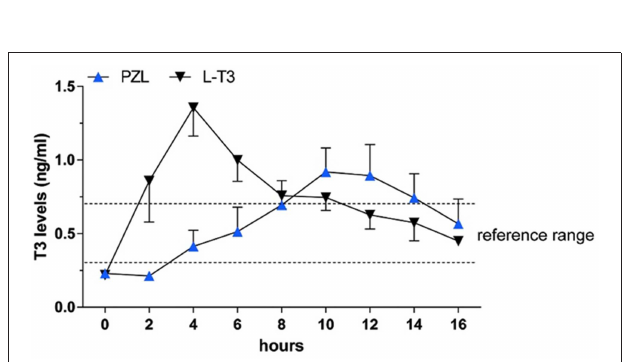
FIGURE 4 | Increasing the period PZL remains at the site of absorption and slowing the rate at which T3 becomes available for absorption, more closely matches T3 production in a healthy subject. By creating a unique “drug depot” from which T3 slowly releases, PZL addresses many of the limitations that have plagued previous attempts to mimic the natural production of T3 in healthy subjects.